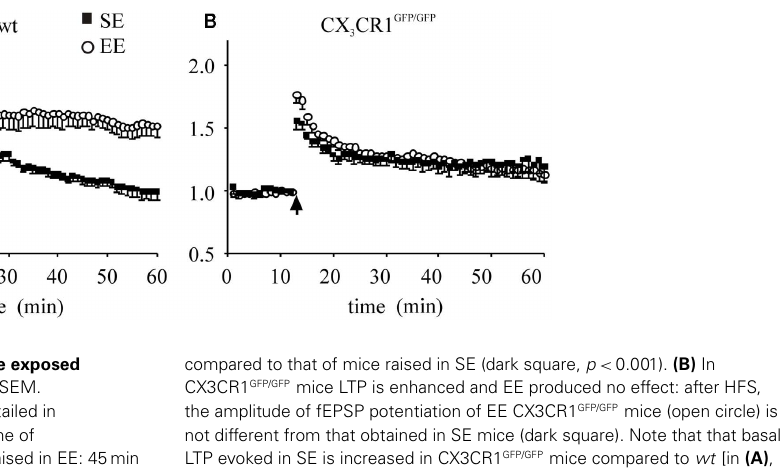
FIGURE 1 | CA1 plasticity of wt and CX 3 CR1 GFP/GFP mice exposed either to SE or EE conditions. Points represent mean ± SEM. Of fEPSP slopes evoked every 20s and normalized as detailed in the Section “Materials and Methods.” Arrows indicate time of application of HFS. (A) Enhancement of LTP in wt mice raised in EE: 45min after HFS, EE wt mice (open circle) developed a robust LTP of fEPSP slope